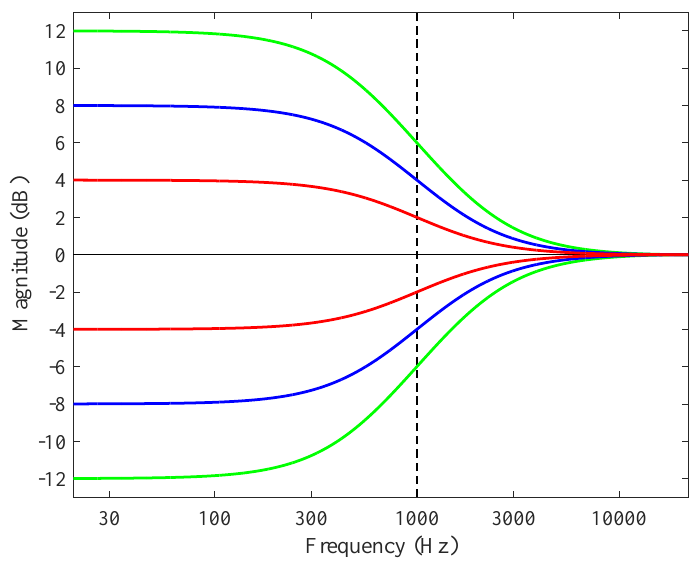
Figure 1. Magnitude responses of low-frequency shelving filters with complementary gains: − 12dB and 12 dB (green), − 8dB and 8 dB (blue), − 4dB and 4 dB (red). The vertical dashed line indicates the crossover frequency (1kHz) where midpoint gain is